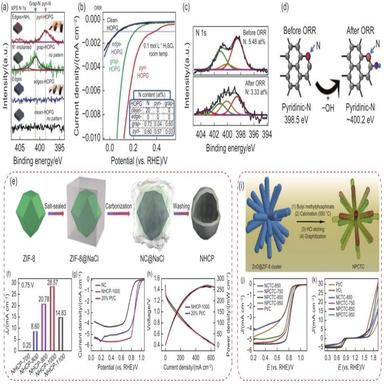
a) N 1s XPS spectra of N-modified HOPG. (b) ORR results for corresponding N-modified HOPG in (a). (c) N 1s XPS of the N-modified HOPG sample catalyst before and after ORR. (d) Catalysis mechanism of the active site. Reproduced with permission. Copyright @ 2016 American Association for the Advancement of Science. (e) Schematic of the formation of N-doped hollow carbon from ZIF-8. (f) Current density measured at 0.75 V (vs. RHE). (g) ORR curves and (h) discharge curve and corresponding power density of N-dope